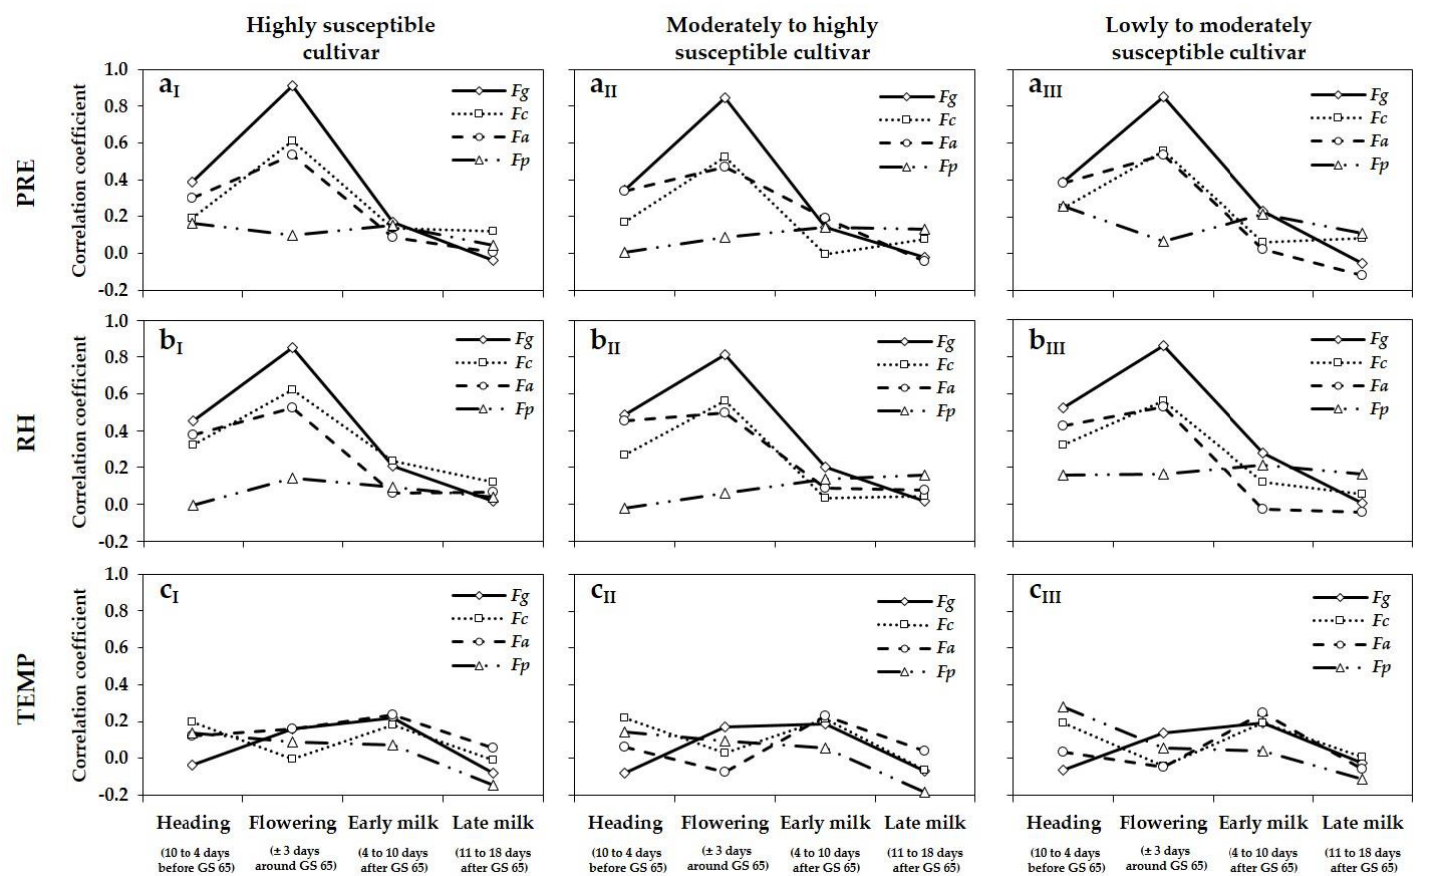
Figure 5. Curves of correlation coefficients ( r ) between meteorological variables ( a ) PRE (cumulative precipitation, mm), ( b ) RH (relative humidity, %) and ( c ) TEMP (mean temperature, ◦ C) 10 to 4 days before GS 65 (heading), ± 3 days around GS 65 (flowering), 4 to 10 days after GS 65 (early milk stage) and 11 to 18 days after GS 65 (late milk stage) and DNA amounts (pg fungal DNA / ng plant DNA) of F. graminearum ( Fg ), F. culmorum ( Fc ), F. avenaceum ( Fa ) and F. poae ( Fp ) in wheat grain of the highly (I), the moderately to highly (II) and the lowly to moderately susceptible cultivar (III) and of the seven trial locations (three replications per location) in northern Germany summarized for the years 2013 to 2017. n = 315.